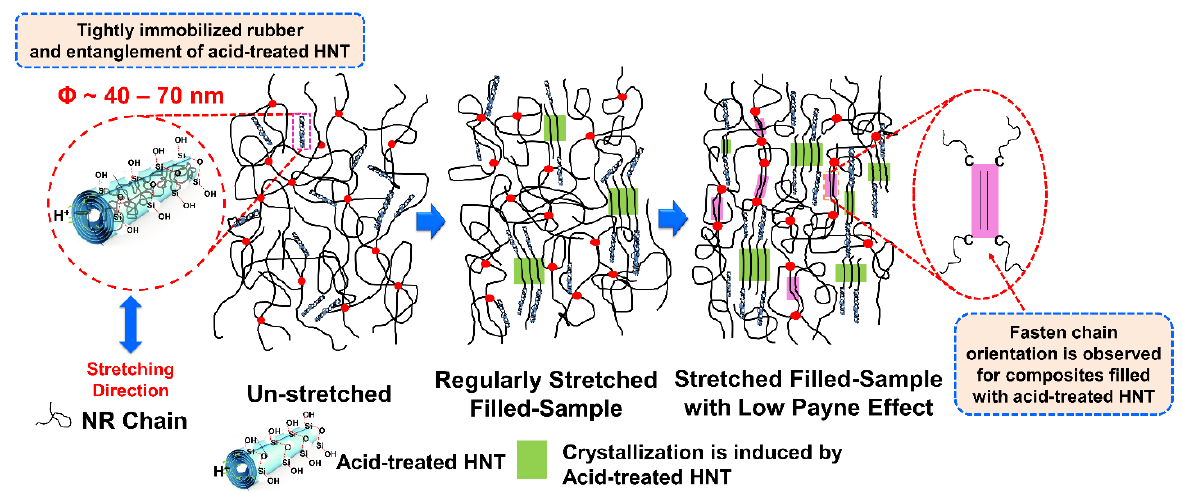
Figure 14. Schematic model representing the crystallization development of ENR/HNT composites filled with acid-treated HNT.